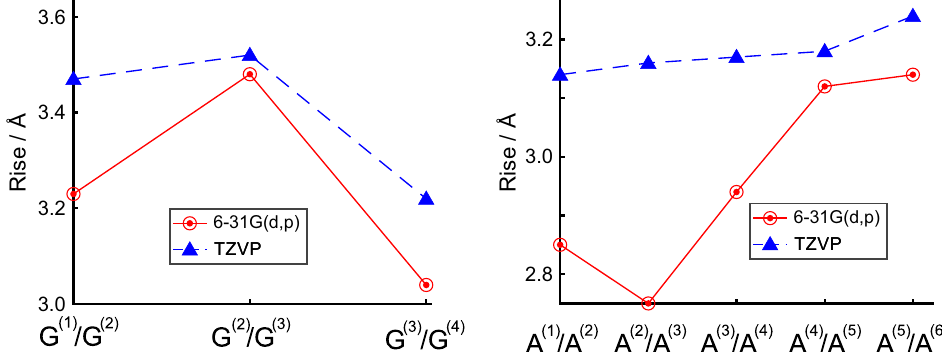
Figure 2. Predicted rise coordinates of ds-G 4 (( left ) B3LYP-D3) and ss-A 6 (( right ) M06-2X) using different basis